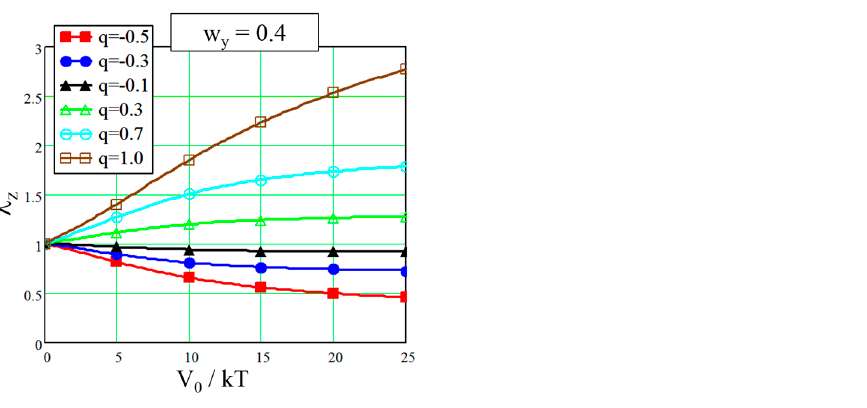
Figure 6. Elongation ratio λ z as functions of the parameter V 0 /kT at w y = 0.4 and at varying structural parameter q .